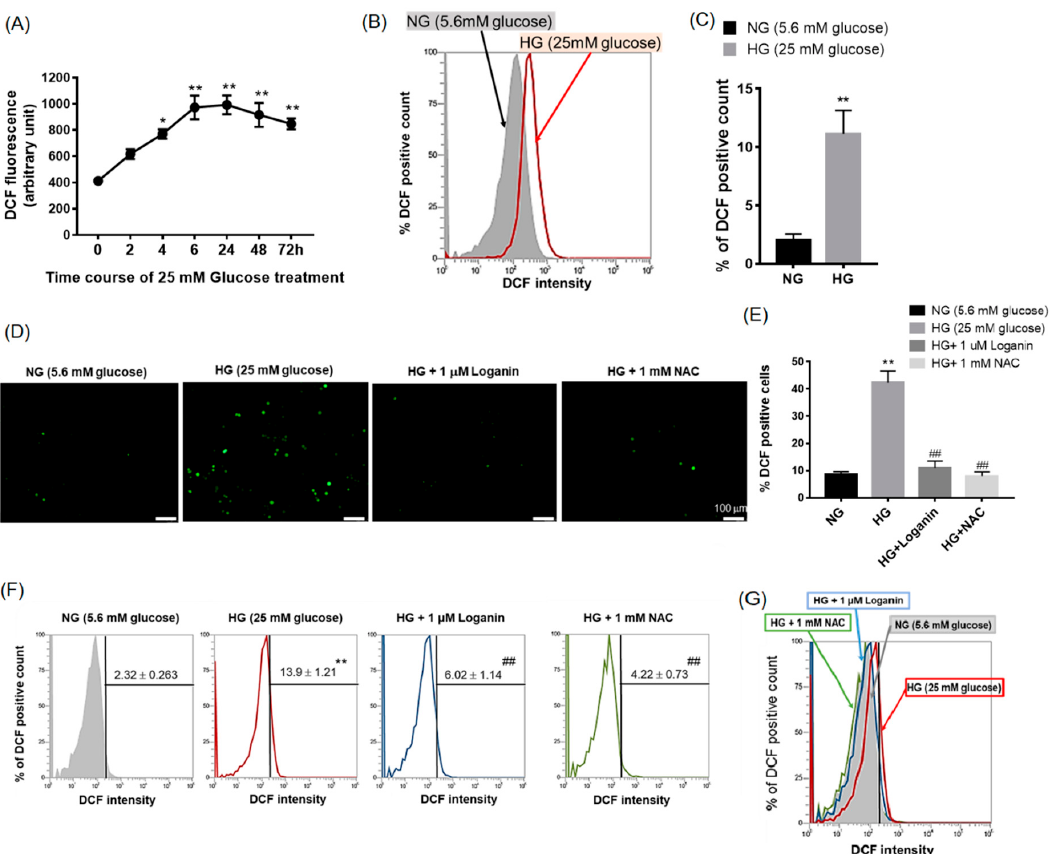
Figure 2. Effect of high glucose and loganin on intracellular ROS generation in rat RSC96 Schwann cells assayed by 2 ́ ,7 ́ -dichlorofluorescein–diacetate (DCFH 2 –DA) staining. ( A ) Intracellular reactive oxygen species (ROS) levels of 25-mM-HG-treated RSC96 cells in 96-well plates were measured by the fluorescence intensity using a fluorescence spectrophotometer; ( B ) fluorescence intensity measured by flow cytometry. Overlay flow cytometry histograms represent DCF fluorescence in the 25-mM-HG-treated group (red line) and 5.6-mM NG (gray area); ( C ) quantitative analysis of DCF fluorescence intensity. To evaluate the antioxidant effect of loganin, N-acetyl-L-cysteine (NAC) antioxidant was added as a control group. RSC96 cells were incubated with 1- μ M loganin or 1-mM N-acetylcysteine for 48 h; ( D ) Images were obtained using a fluorescence microscope (magnification, ×100; scale bar, 100 μ m) with DCF-positive cells in green and ( E ) reflected as positive cells in each view (mean ± SEM, n = 6); ( F ) fluorescence intensity measured by flow cytometry; ( G ) overlay flow cytometry histograms of cultures. An increase in DCF fluorescence was observed in the HG-treated group (red line) with no change in 25-mM HG with 1- μ M loganin (blue line) or 1-mM NAC (green line) treatment, compared with 5.6-mM NG (gray area). Values represent triple-repeated experiments and average DCF fluorescence intensity fold change relative to the NG group. * p < 0.05 and ** p < 0.01 vs. NG group; ## p < 0.01 vs. HG group.